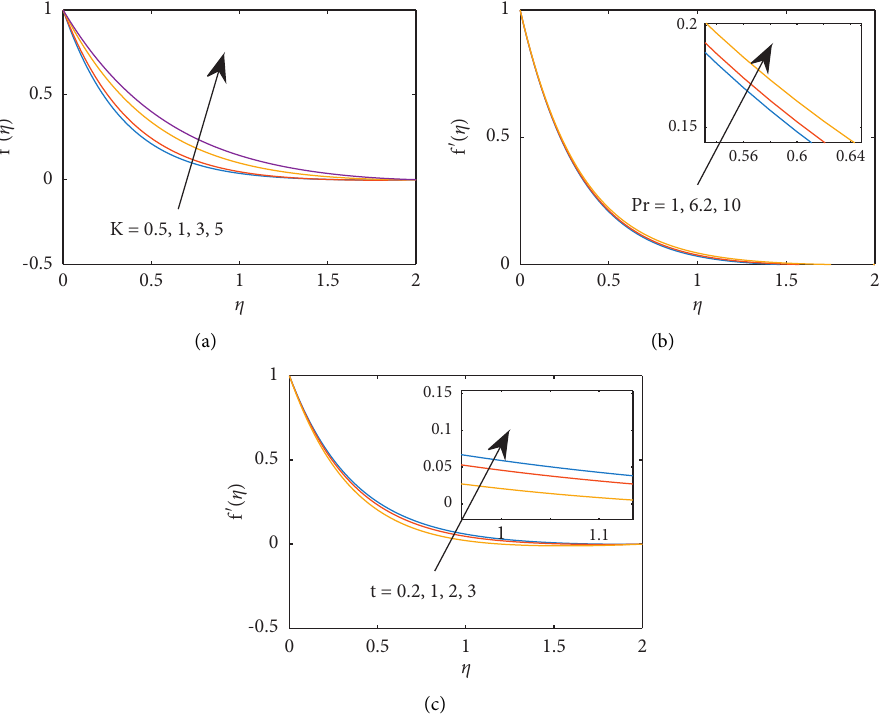
Figure 9: Impact of (a) K